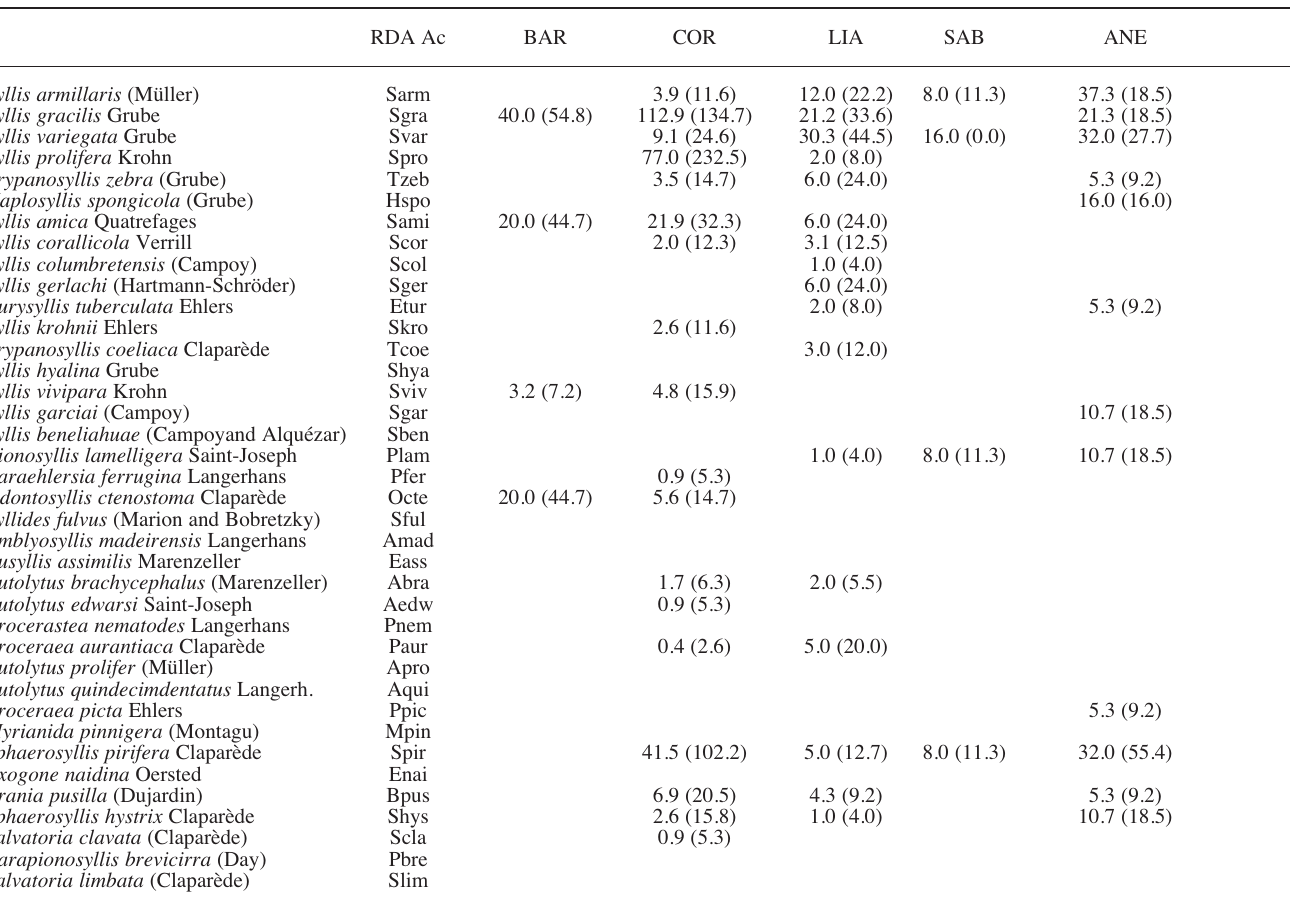
TABLE 1. – Syllids collected in the study area listed in decreasing order of total density (ind. m -2 , standard deviation in brackets) within each subfamily (Syllinae, Eusyllinae, Autolytinae, Exogoninae), and per habitat (see acronyms in Materials and methods). Species acronym used in RDA is listed (RDA